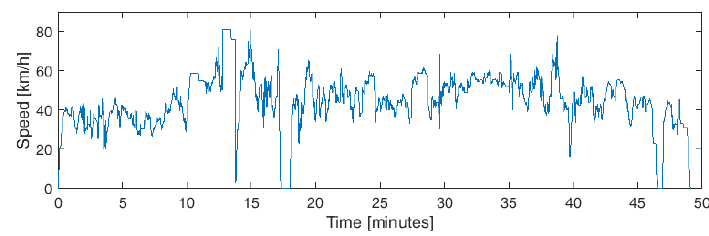
Figure 13. Altitude profile, extra-urban 1.